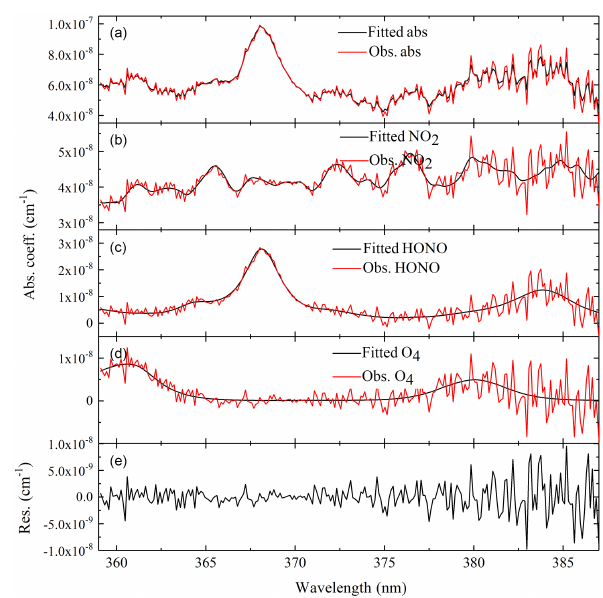
Figure 8. Example of retrieved and fitted absorption spectra of NO 2 and HONO measured at 12:44CST on 28 June. (a) shows the ab- sorption measurement by IBBCEAS. The absorption features due to NO 2 and HONO can be clearly seen. (b–d) show the same spec- trum plotted in the first panel. They are decomposed into individ- ual absorption contributions from NO 2 (3 . 05 ± 0 . 17ppb), HONO (2 . 53 ± 0 . 093ppb) and O 4 ([O 2 ] is close to 21%). (e) is the residual spectrum (standard deviation = 2.76405 × 10 − 9 cm − 1 )